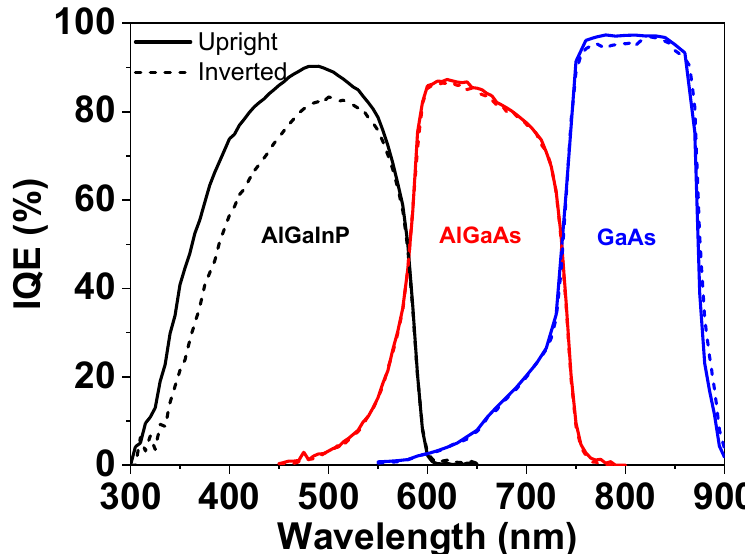
Figure 2. IQE spectra of fabricated AlGaInP/AlGaAs/GaAs (2.1 eV/1.7 eV/1.4 eV) T-3J solar cells grown in upright (solid line) and inverted structure (dashed line). Inverted 2.1 eV AlGaInP sub-cell presents decreased IQE compared with upright reference.